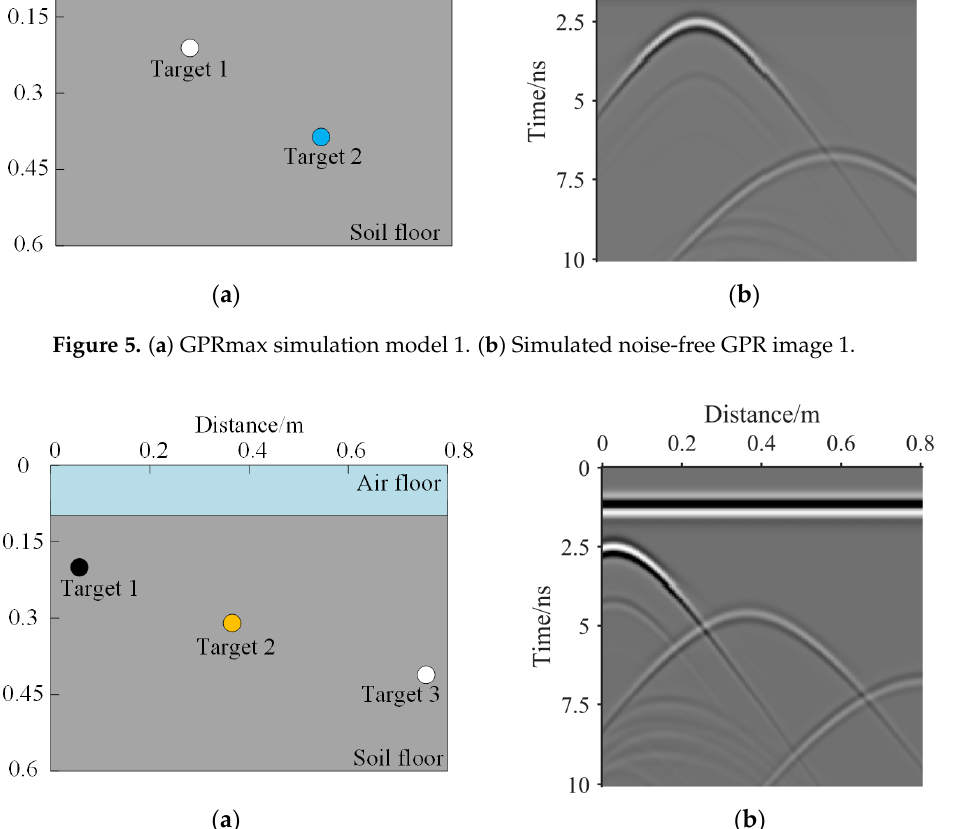
Figure 7. Simulated noise trend curve. Figures 8 and 9 show the denoising results of simulated GPR image 1 and image 2, respectively. From a visual perspective, the following conclusions can be drawn: The bilateral filter: Figures 8b and 9b are the denoising results of the bilateral filter with a local window radius of 5 and a range and spatial parameters of 40, respectively. After denoising, the basic outline of the effective signal of the image is preserved. How- ever, there is still considerable residual noise in the image. The guided filter: Figures 8c and 9c are the denoising results of the guided filter with a local window radius of 5 and the regularisation parameter of 50 2 . The residual noise of the image after denoising is less than that denoised by the bilateral filter, and the protec- tion of effective signal is similar to that processed by the bilateral filtering. However, after denoising, the image contrast weakens. NSST-1: Figures 8d and 9d are the denoising results of NSST with the noise standard deviation of 10. Among the denoising results of NSST-1, NSST-2, NSST-3 and NSST-4, the edge information denoised by NSST-1 at 0 ns–5 ns is best preserved. However, the resid- ual noise denoised by NSST-1 at 5 ns–10 ns has the worst suppression effect. This is be- cause the noise standard deviation of 10 is suitable for the noise of shallow underground; however, it is small for the noise from deep underground. NSST-2: Figures 8e and 9e are the noise removal results of the NSST with the noise standard deviation of 20. The edge information destruction at 0–5 ns is more severe than